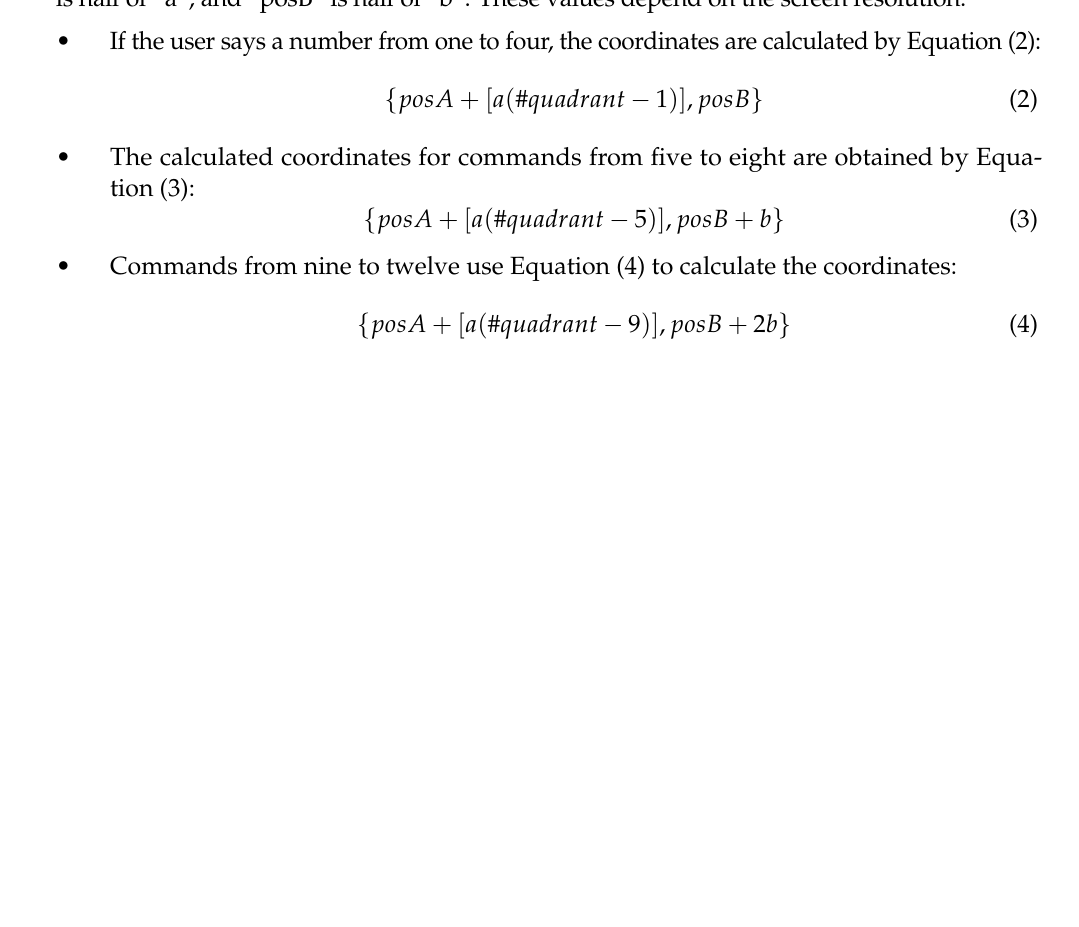
Table 2. Cont. Command Function “inicio” (beginning) Click on the start icon in the left corner. Click in the lower right corner on the quick access bar of the desktop in Windows and “escritorio” (desktop) position the cursor in the center of the screen (exclusive for Windows). “centro” (center) Position the cursor in the center of the screen. “clic” (click) Click. “doble” (double) Double-click. “derecho” (right) Right-click. “sujetar” (hold) Hold left click. “soltar” (release) Release left click. “cerrar” (close) Close the current window. “minimizar” (minimize) Minimize the current window. Open the menu of open windows (exclusive for “ventanas” (windows) Windows). “enter” Perform the function of the “ENTER” key. “dictado” (dictation) Activate dictation mode. “salir dictado” (exit dictation) Deactivate dictation mode. “apagar” (turn